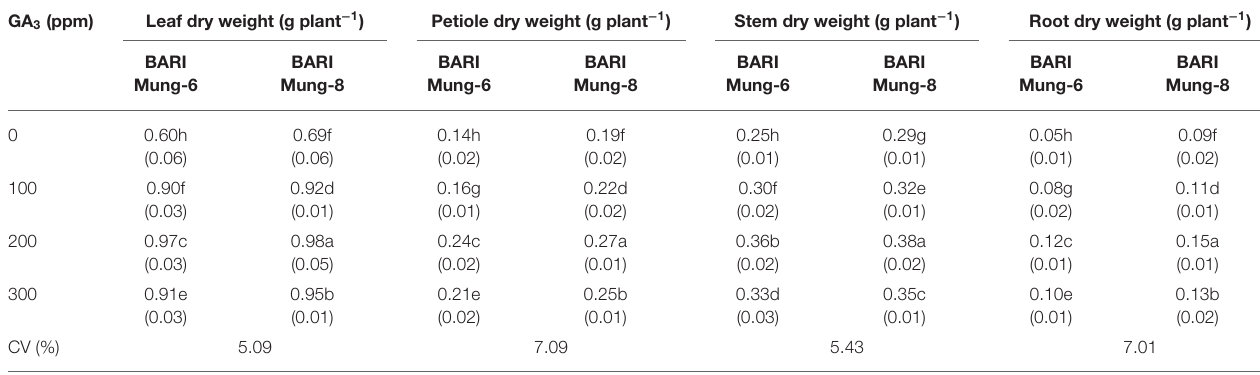
TABLE 6 | Effect of GA 3 on the dry matter in different plant parts of V. radiata varieties. GA 3